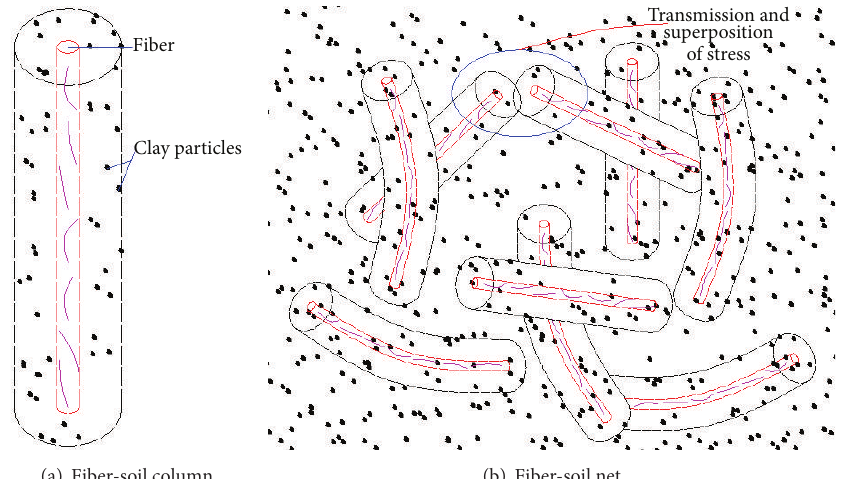
Figure 6: Model of fiber and soil column-net.